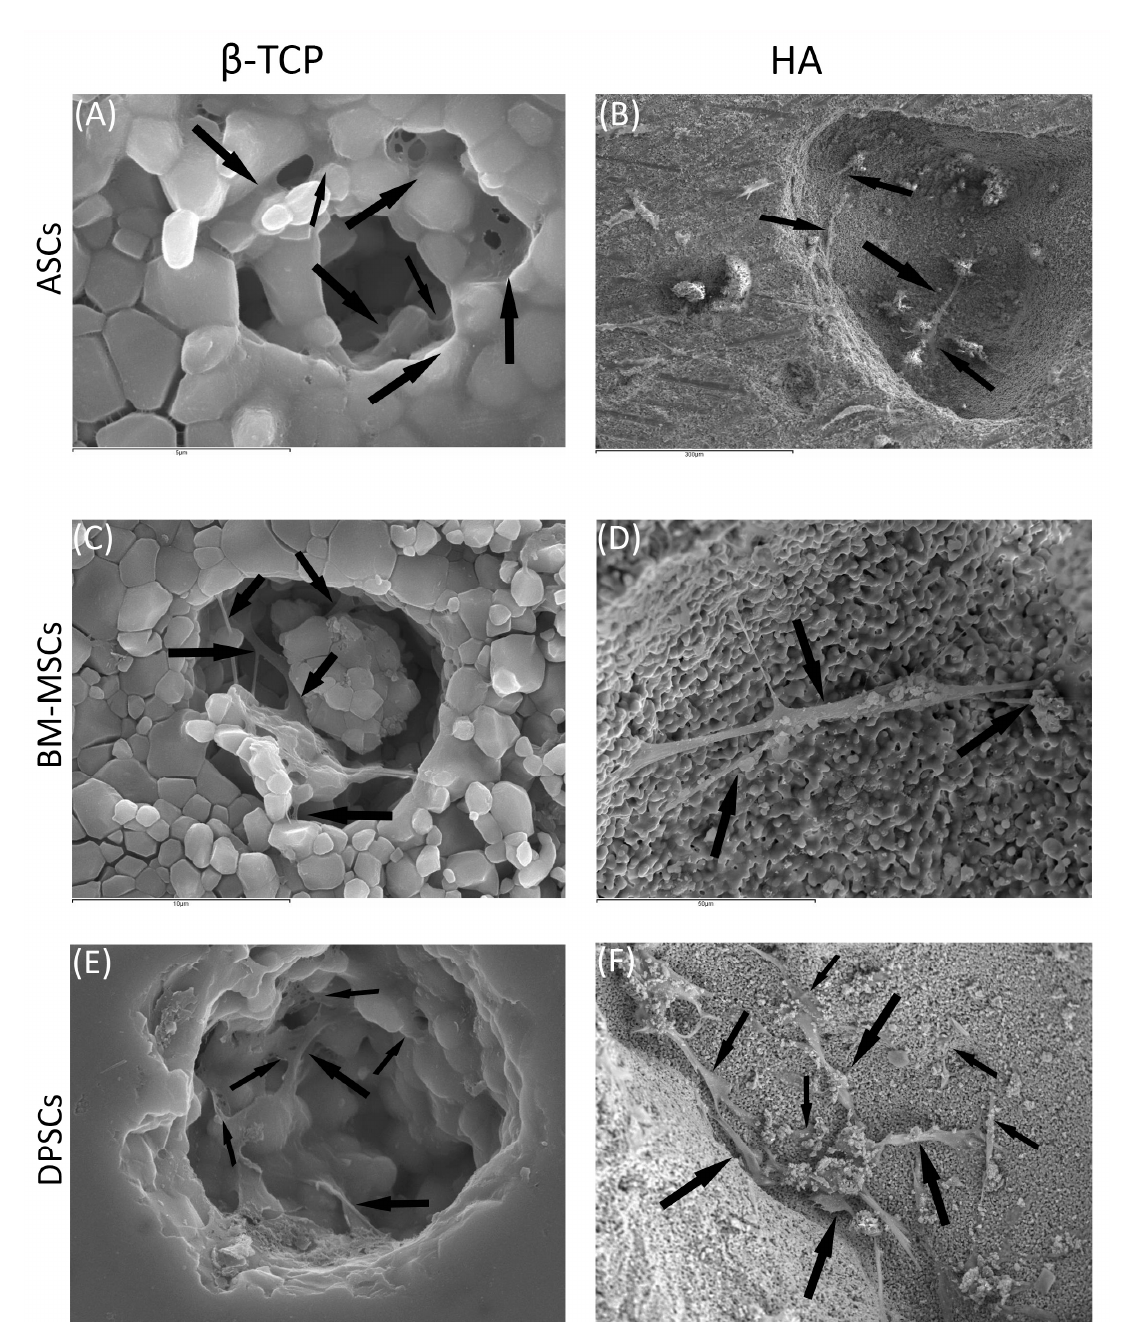
Figure 5. MSCs colonising pores of both HA and ß-TCP scaffolds after 24 h: ( A ) existing pores in HA colonised by DPSCs (scale bar: 5 µ m); ( B ) existing pores in HA colonised by BM-MSCs (scale bar: 300 µ m); ( C ) existing pores in HA colonised by ASCs (scale bar: 10 µ m); ( D ) existing pores in ß-TCP colonised by DPSCs (scale bar: 50 µ m); ( E ) existing pores in ß-TCP colonised by BM-MSCs (scale bar: 10 µ m); and ( F ) existing pores in ß-TCP colonised by ASCs (scale bar: 200 µ m). Black arrows indicate unique